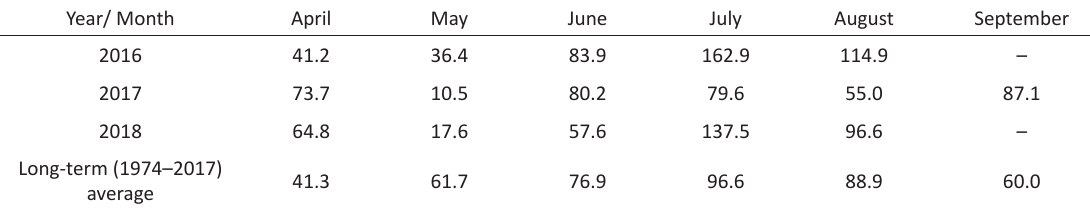
Table 2. Rainfall (mm) during faba bean vegetative seasons, Kaunas Meteorological